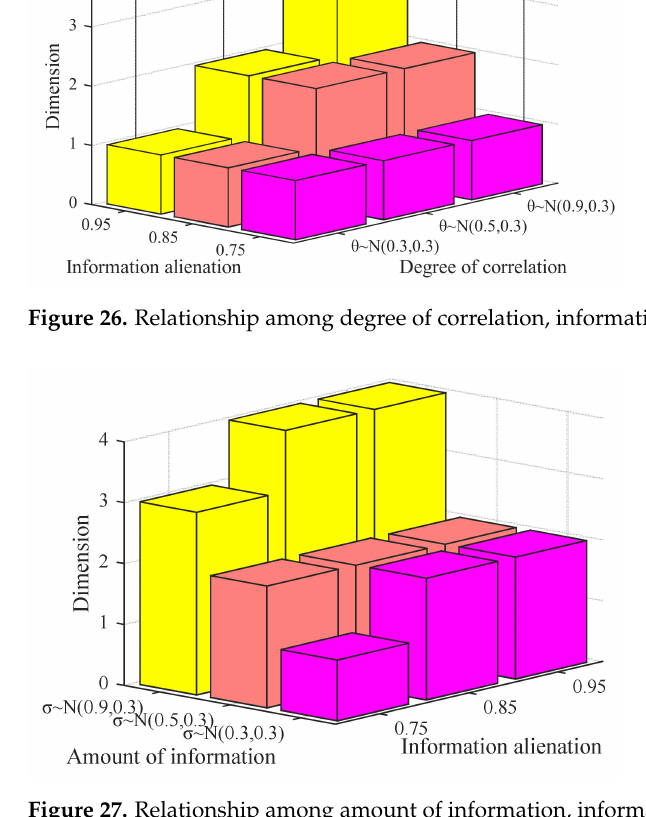
Figure 27. Relationship among amount of information, information alienation and